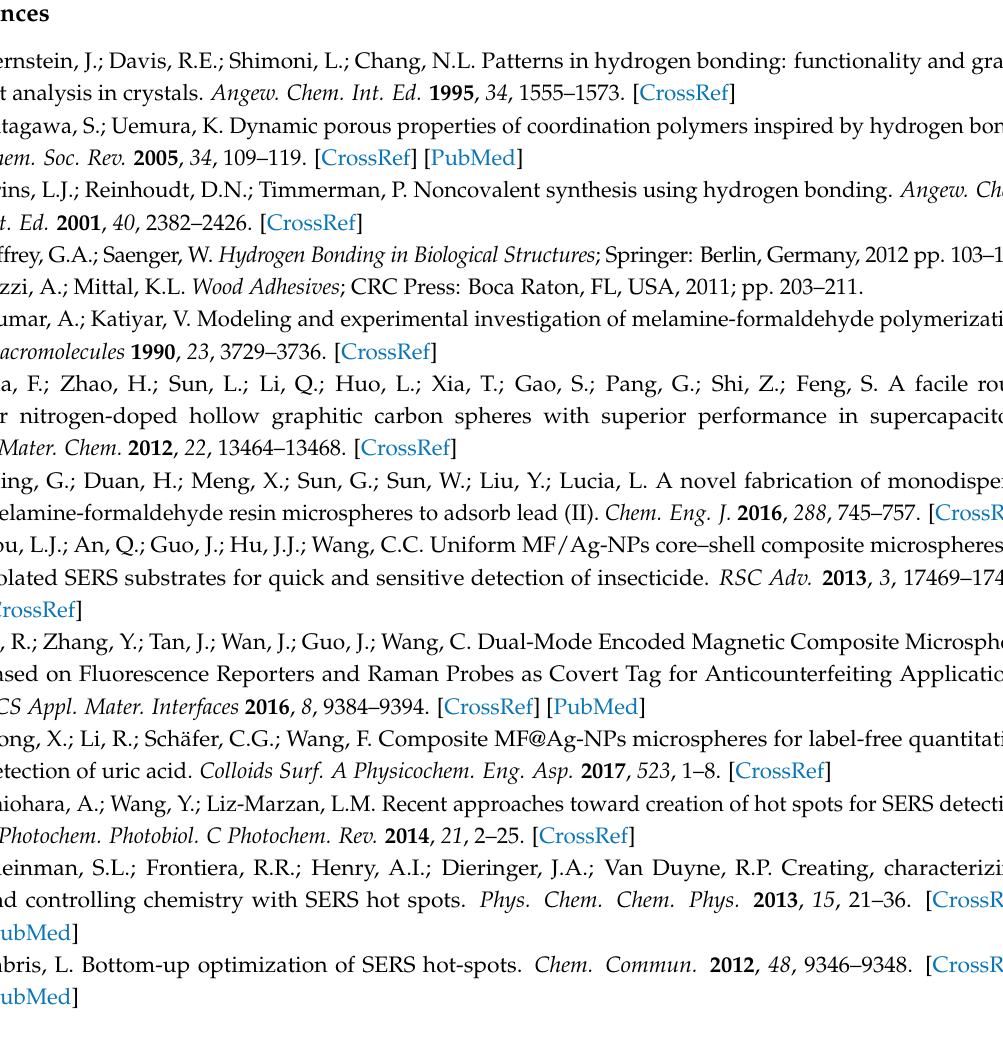
Figure S1: XRD analysis of AgNPs loaded on a set of MFMSs; Figure S2: Terminal overreaction between the –NH 2 around a two-dimensional resin molecule and the excessive CH 2 O remained in the reaction solution; Figure S3: Severe aggregation of AgNPs loaded on MF 1 ; Figure S4: SERS spectra from R6G molecules in different concentrations on AgNPs loaded on MF 3 synthesized in 8 h; Figure S5: Comparison between the 610 cm − 1 Raman and SERS on AgNP/MFMSs bands of R6G; Figure S6: R6G SERS spectra collected on a set of randomly-selected AgNP/MF 7 MSs; Figures S7 and S8: Optical images of MFMSs and AgNP/MFMSs under a confocal Raman spectroscope; Figures S9 and S10: SERS spectra from R6G on AgNPs loaded on MFMSs using 532 nm and 785 nm laser, respectively; Table S1: Particle sizes of MFMSs synthesized under a set of M:F molar ratios; Table S2: